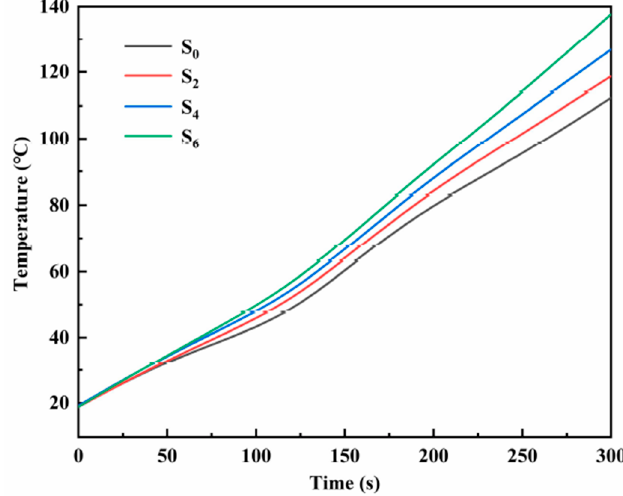
Figure 10. The temperature variation curve of the same geometric position of samples S 0 , S 2 , S 4 , and S 6 with heating time.